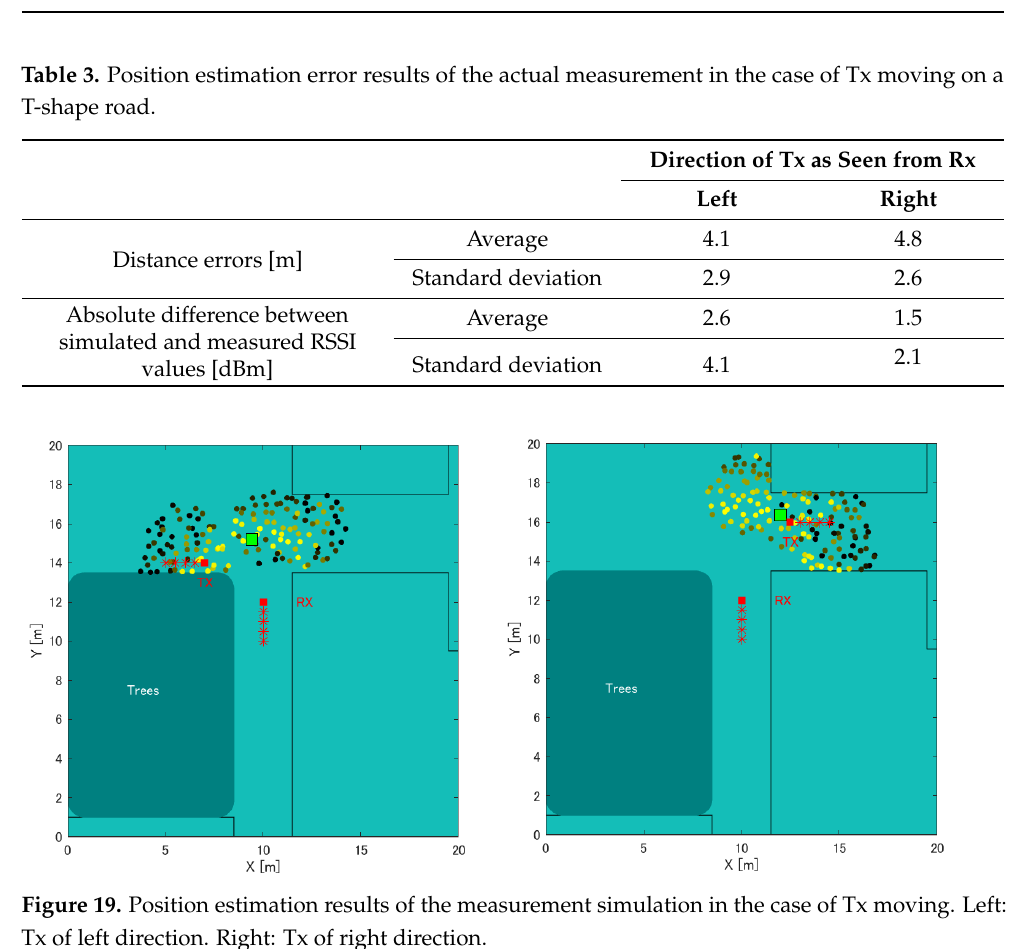
Figure 19. Position estimation results of the measurement simulation in the case of Tx moving. Left: Tx of left direction. Right: Tx of right direction.